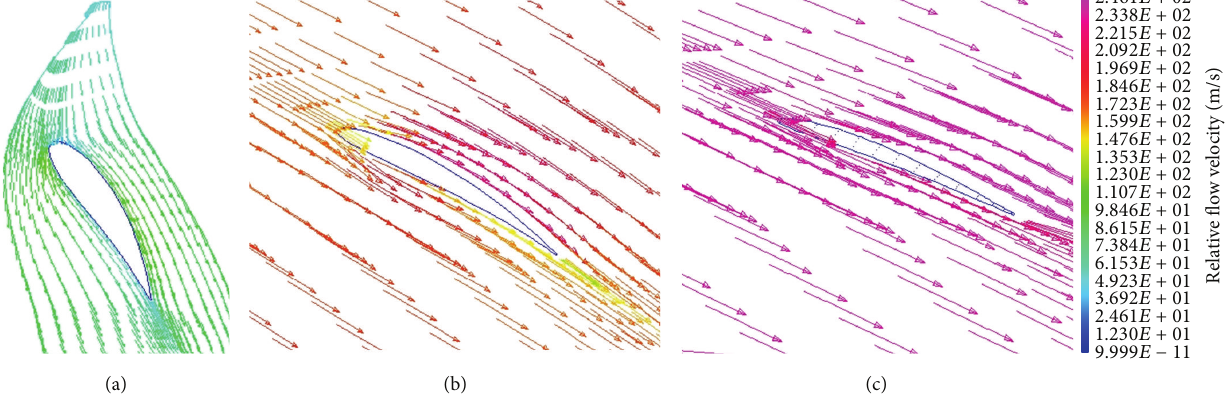
Figure 4: Relative flow velocity vectors: (a) near hub, (b) at 𝑅75 , and (c) at blade tip.